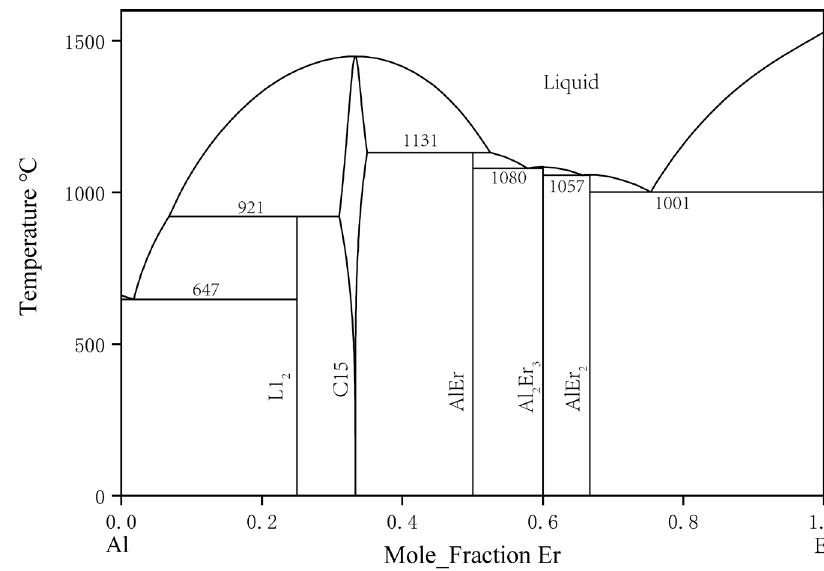
Figure 3. Calculated Al–Er phase diagram by Cacciamani et al. [28].